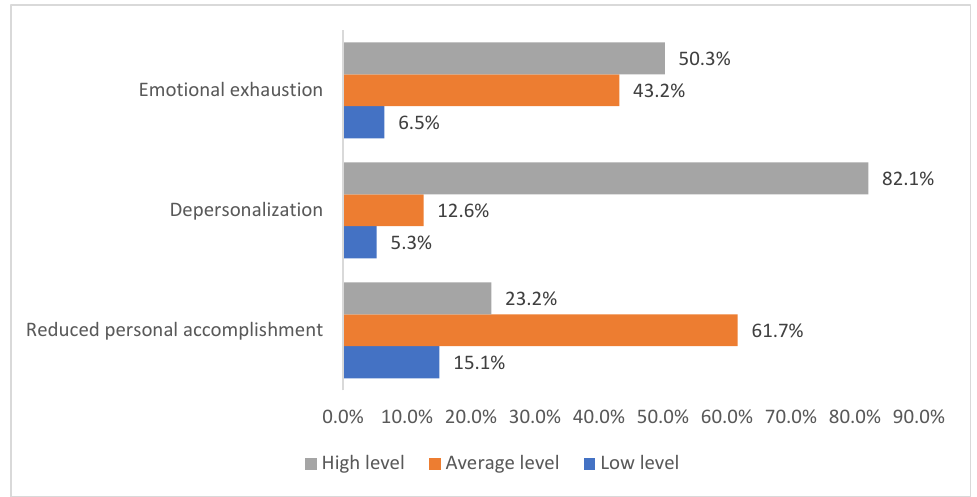
Figure 6. The frequency distribution of COVID-19 ICU physicians by the levels of severity of components of occupational burnout.